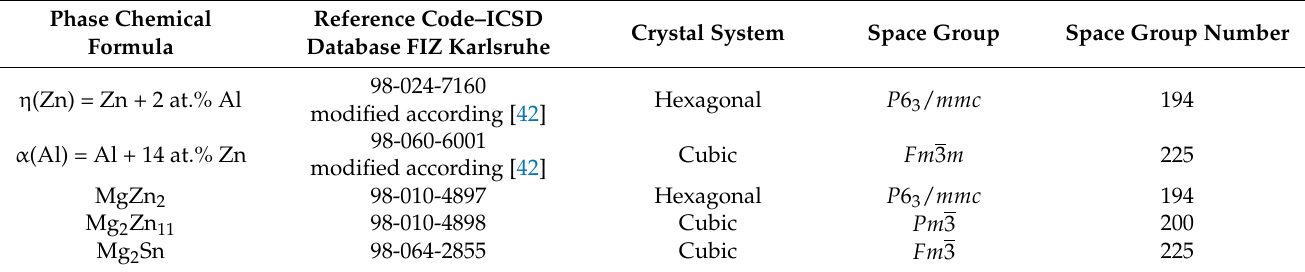
Table 3. Phases identified during XRD analysis.